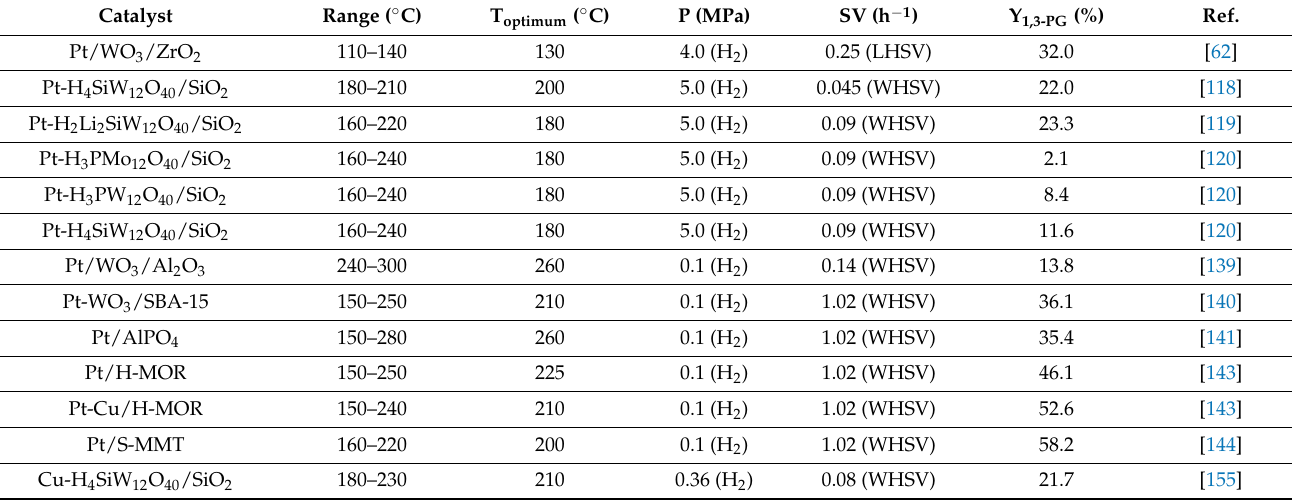
Table 10. The thermal effect studied in continuous flow reactors using different catalysts.